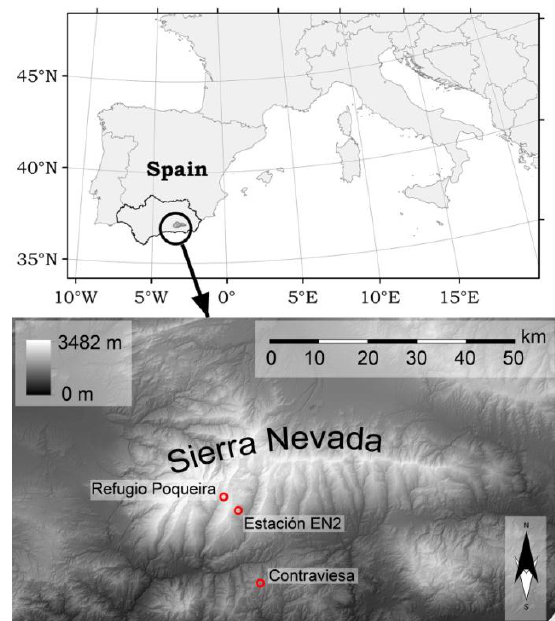
Fig. 1. Location of Sierra Nevada in Andalusia, Spain, and the weather stations used in this study (Refugio Poqueira and EN on the Southern slope of Sierra Nevada; Contraviesa facing North on the opposite mountain range).